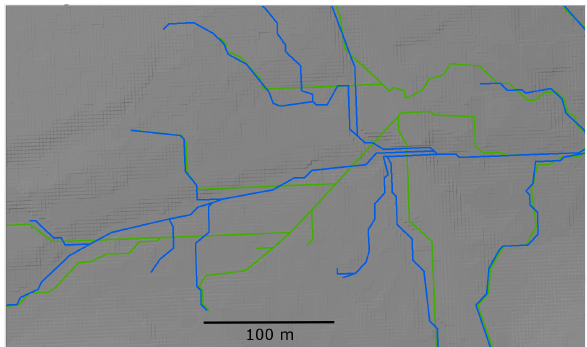
Figure 2: Drainages obtained after filling (green) and after breaching (blue) on a one-metre resolution DTM (Hutchinson, 1989). However, it requires an a priori knowledge of the hydrography and existing maps (when they exist) lack of data and precision compared to LiDAR data. A second approach is the filtering of the terrain with a low-pass filter or a focal oper- ation which assigns to a pixel the lowest elevation within a win- dow. Filtering removes small pits by smoothing the terrain but it works only for pits smaller than the window. Nonetheless, it is often used to remove noise and enlarge existing channels before applying other